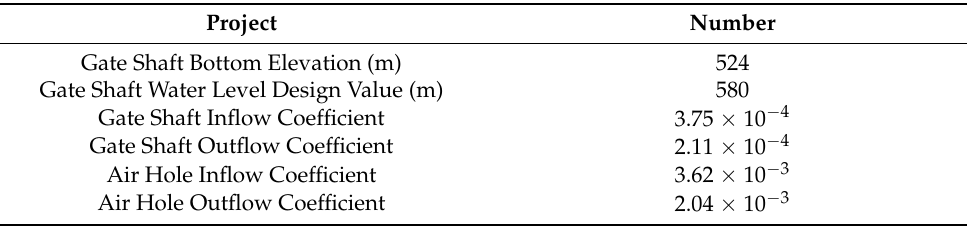
Figure 5. Diagram of B power station. Table 3. Parameters of B power station.